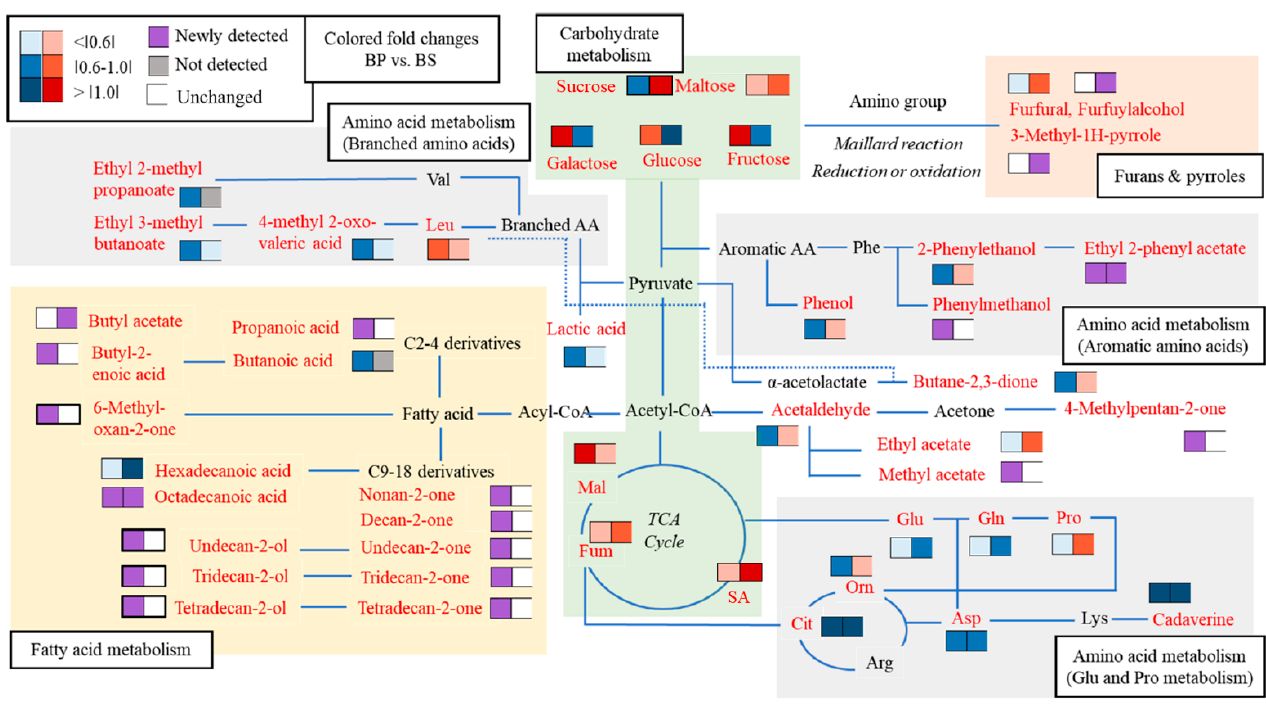
Figure 3. The possible metabolic pathways of specific metabolites obtained at phase Ⅲ in B. subtilis . The fold changes (>1.5) compared to BC were visualized by heatmaps. Metabolites showing significant changes compared to the control are written in red letters. Up-expressed metabolites are represented by a red color, while down-expressed metabolites are shown in a blue color. Abbreviations